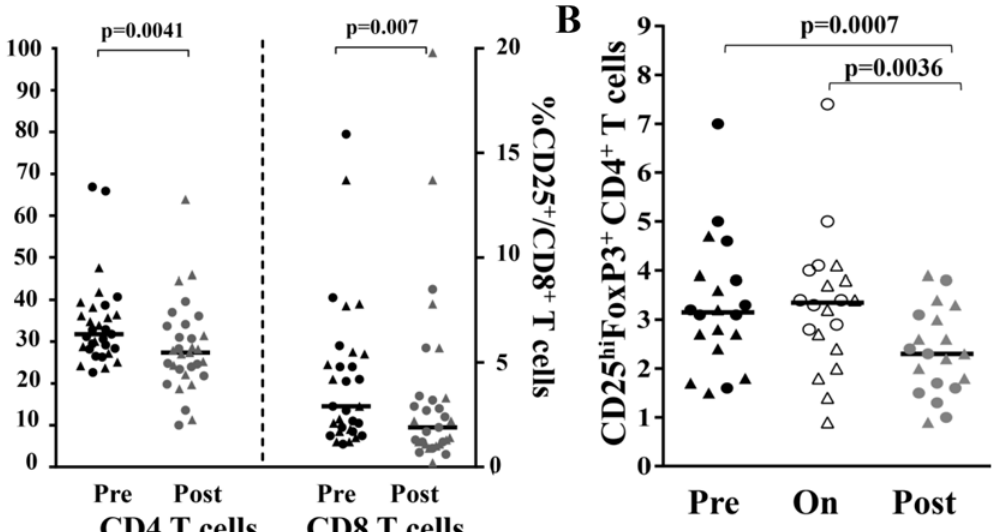
Fig 4. Identification of activated and regulatory T cell populations by flow cytometry. (A) Freshly isolated cells were stained for CD3, CD4, CD8 and CD25 for identification of activated T cells. Data obtained from 31 subjects (circles for SSG subjects and triangles for TM subjects) for which pre-treatment (black) and post-treatment (grey) cells were available. Bars represent medians. (B) Identification of Treg cells from thawed PBMC. Aggregate data from 20 donors for CD4 + CD25 high Foxp3 + . P values derived using the Wilcoxon matched pairs test.